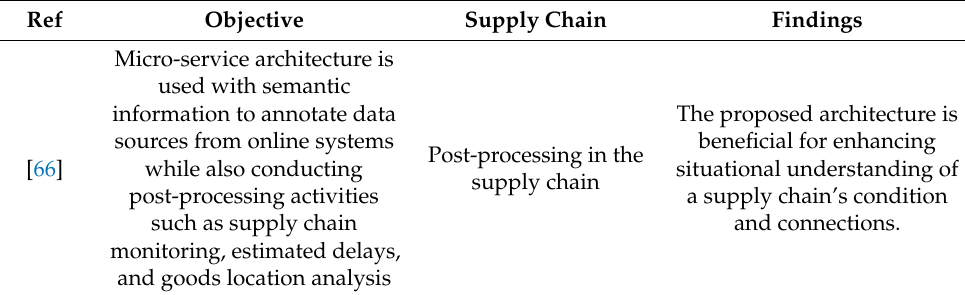
Figure 8. Application of AI in sustainable SCM. Table 3. AI for sustainable SCM.